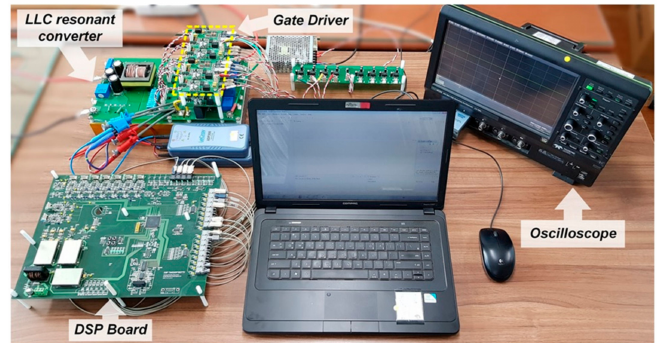
Figure 10. Test setup for series-connected SiC-MOSFETs LLC resonant